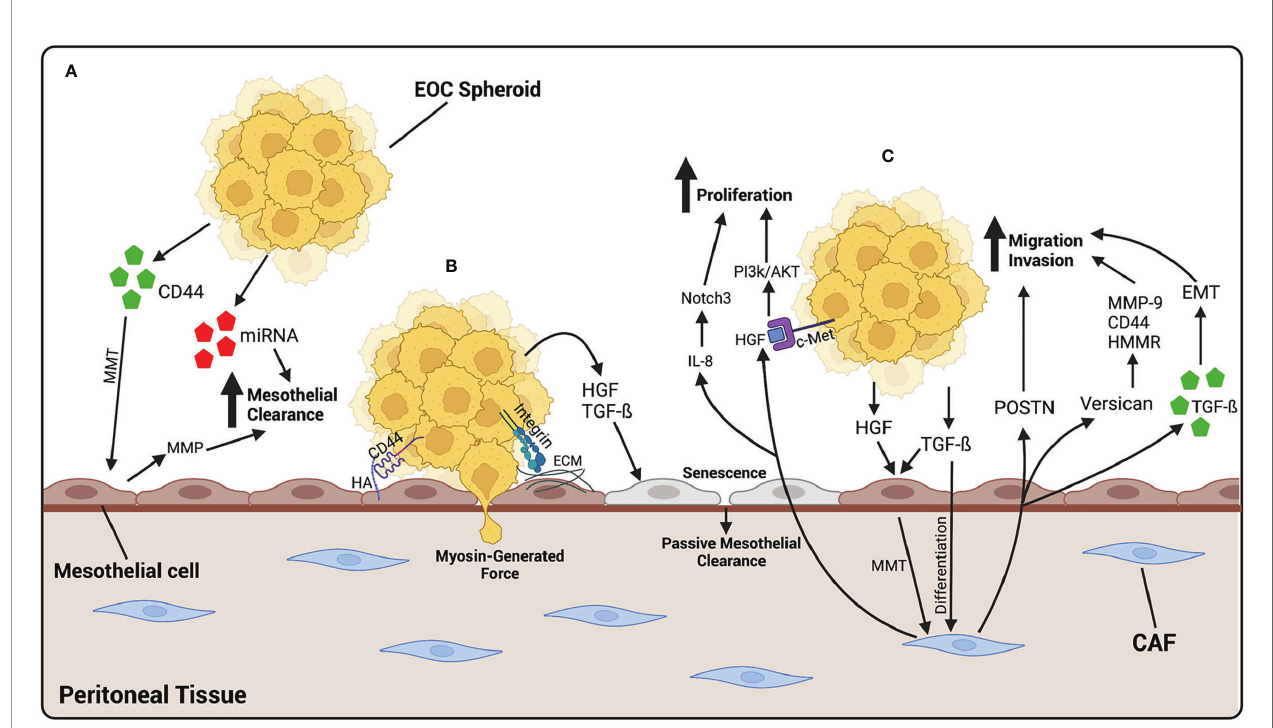
FIGURE 3 | EOC metastasizes to the peritoneal tissue, where it binds and invades through mesothelial cells. (A) EOC cells release CD44 which cause MMT of mesothelial cells, giving them a more fi broblast-like function. MMP, released by mesothelial cells, and miRNA-containing exosomes, released by EOC cells, increase mesothelial clearance of cancer cells. (B) EOC spheroids adhere to the mesothelium by the binding of CD44 on EOC cells to HA on mesothelial cells or integrins binding to ECM components. Once adhered, EOC cells undergo mesothelial clearance, either by using myosin-generated force, or in a more passive way by generating cellular senescence. HGF and TGF- b released by EOC cells initiates senescence of mesothelial cells, leading to an increase in passive mesothelial clearance. (C) Fibroblasts differentiate into CAFs by TGF- b released by EOC cells. HGF and TGF- b released by EOC also contributes to the activation of CAFs, by initiating MMT in mesothelial cells. Once activated, CAFs release POSTN and versican which contribute to the migratory and invasive abilities of EOC cells. CAFs also release exosomes containing TGF- b which increase the ability of cancer cells to undergo EMT, contributing to an increased ability to invade. CAFs also release HGF which binds to c-Met on EOC cells, activating the PI3k/AKT pathway leading to an increase in proliferation. IL-8 released by CAFs activates the Notch3 pathway also leading to an increase in EOC cell proliferation. Created with